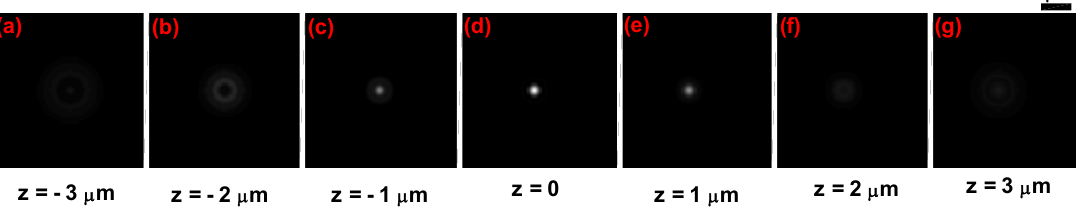
Figure 2. x – y cross section of the computed three-dimensional (3D) point spread function (PSF) for the brightfield microscope used for the experiment.